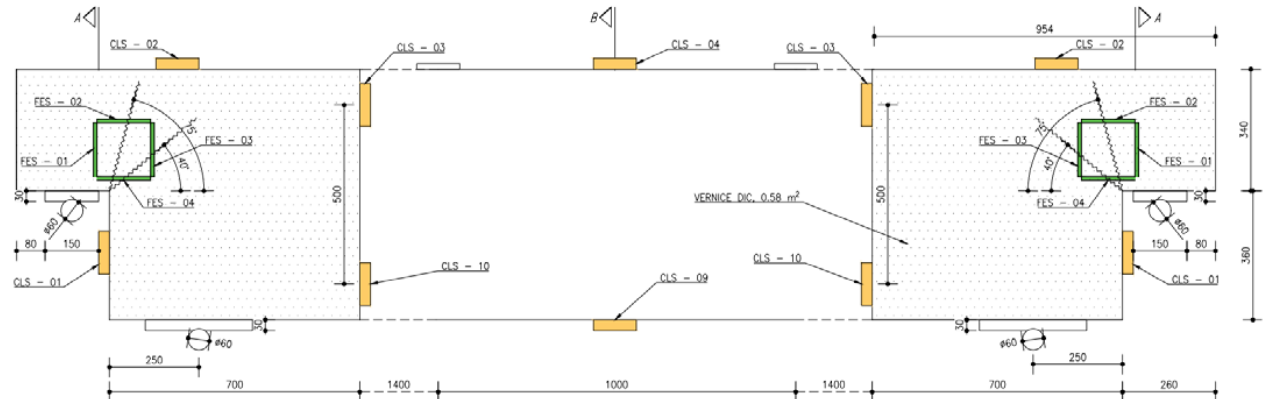
Figure 9. Lateral view of the beam specimen with the monitoring devices.